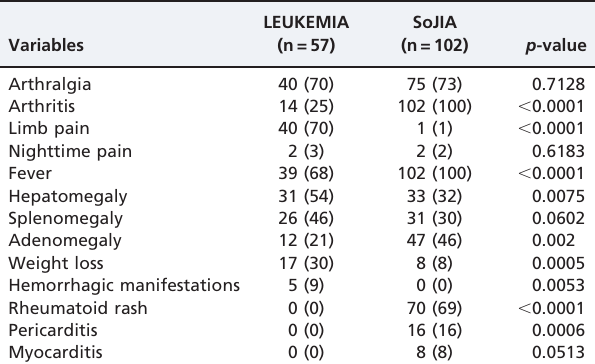
Table 1 - Initial clinical manifestations in acute lymphoblastic leukemia patients vs. systemic-onset juvenile idiopathic arthritis patients.